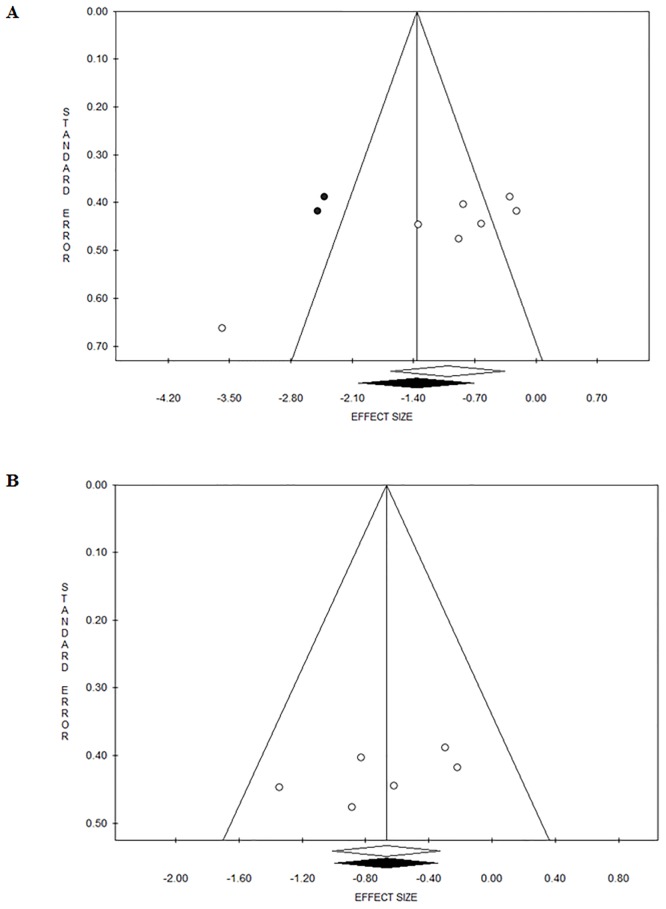
Funnel plot showing evidence of publication bias for the meta-analysis concerning cortisol changes induced by soccer match when pooling all studies, including (3a) and removing (3b) Coelho et al. [29].